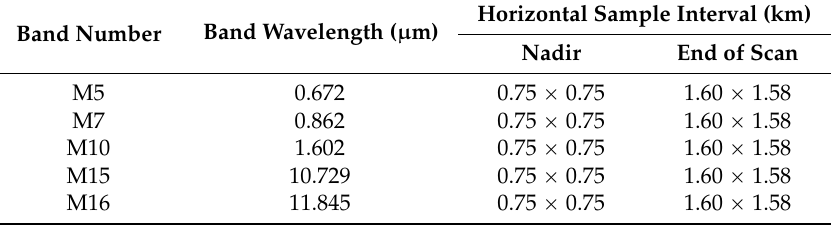
Table 1. Summary of the Visible Infrared Imaging Radiometer Suite (VIIRS) Band Numbers and Wavelengths.